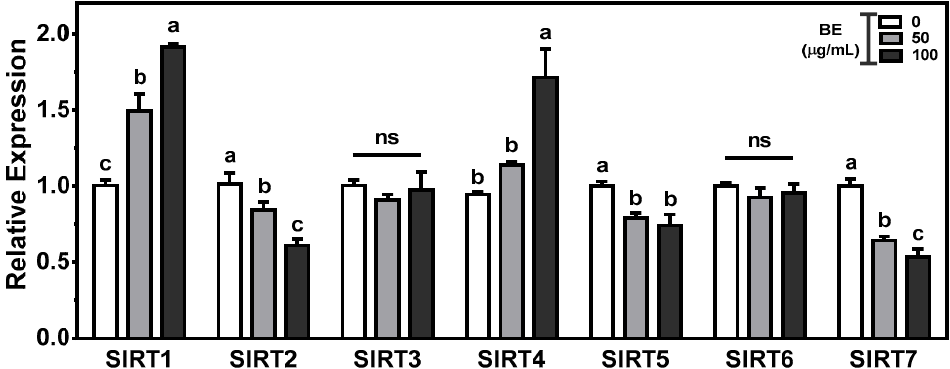
Figure 6. The expression of sirtuins (SIRTs) in BE-treated Caco-2 cells. The cells were treated with 50 or 100 µ g/mL of BE for 24 h. The mRNA expression was measured by qRT-PCR analysis. Data are expressed as relative expressions to control. Bars with different letters are significantly different ( p < 0.05), and ns indicates non-significance ( p > 0.05). Values are means ± S.E.M. n = 6.